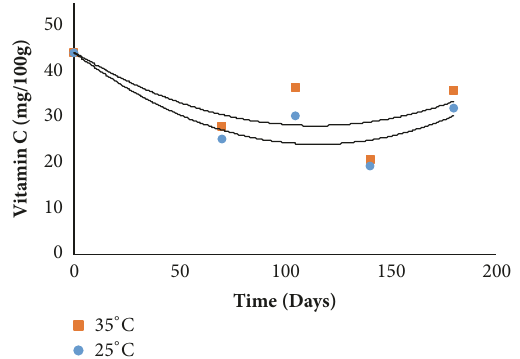
Figure 4: Vitamin C behavior during storage.